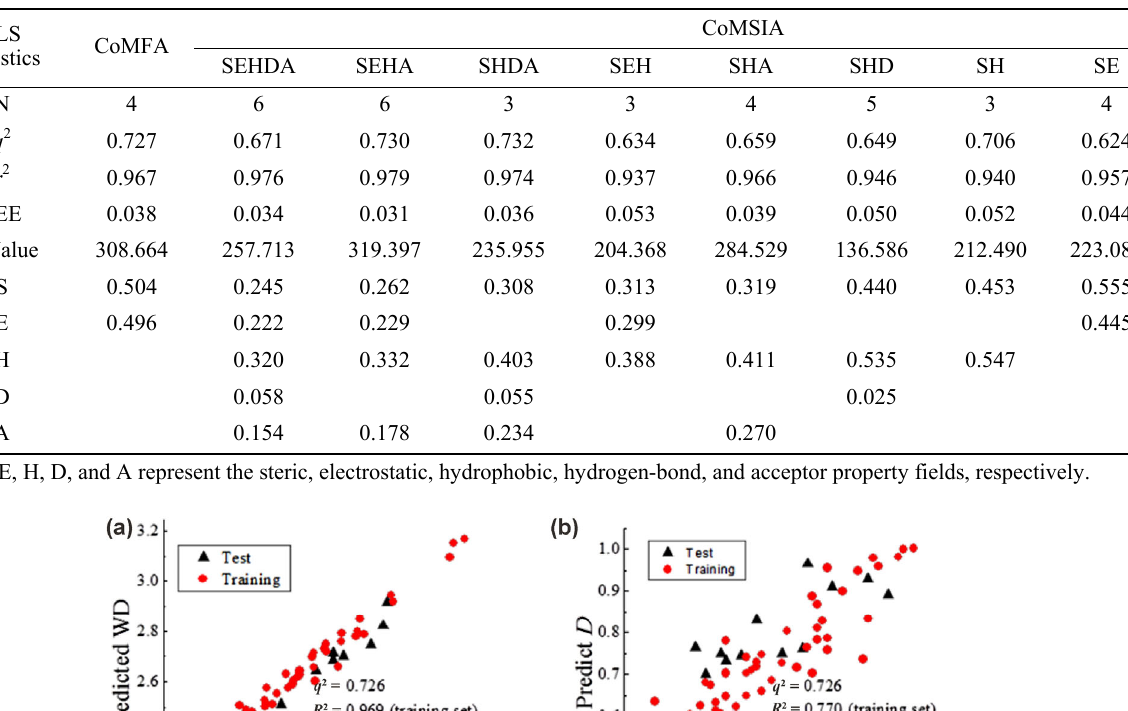
near the green contours and one group inserting the yellow contours, coinciding with their middle WD value.